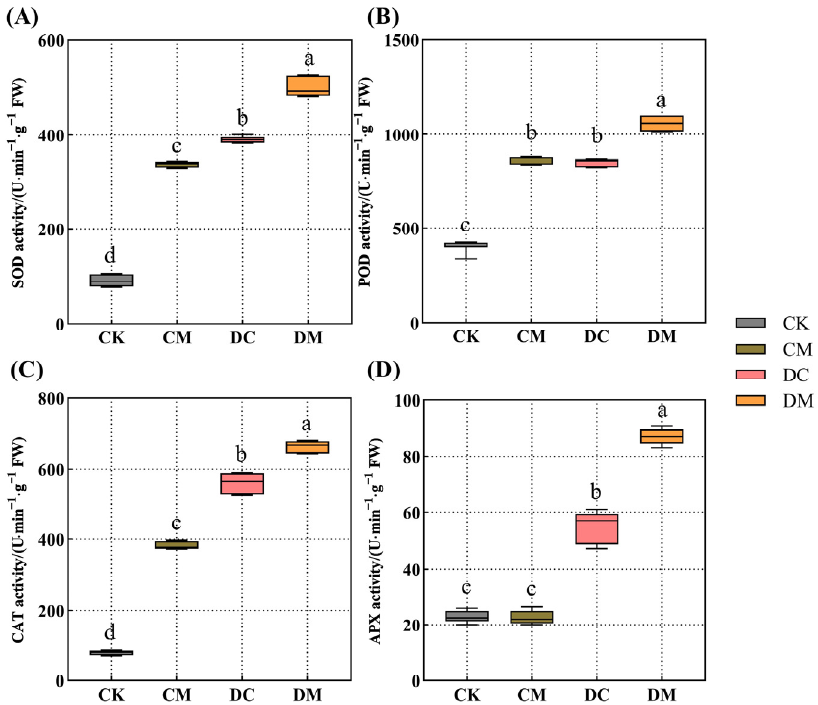
Figure 3. Effect of exogenous melatonin on antioxidant enzyme activity under drought stress. ( A ) SOD activity; ( B ) POD activity; ( C ) CAT activity; and ( D ) APX activity.